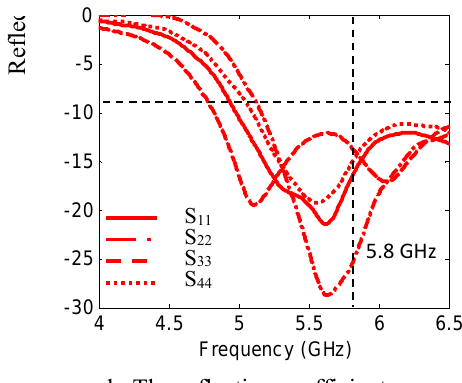
Fig.14. The 3-D view and reflection coefficient of 2×2 circularly polarized DRA array elements mounted on a cylindrical ground plane placed inside a reader device in the presence of human hand model with the same dimensions as in Table 1.